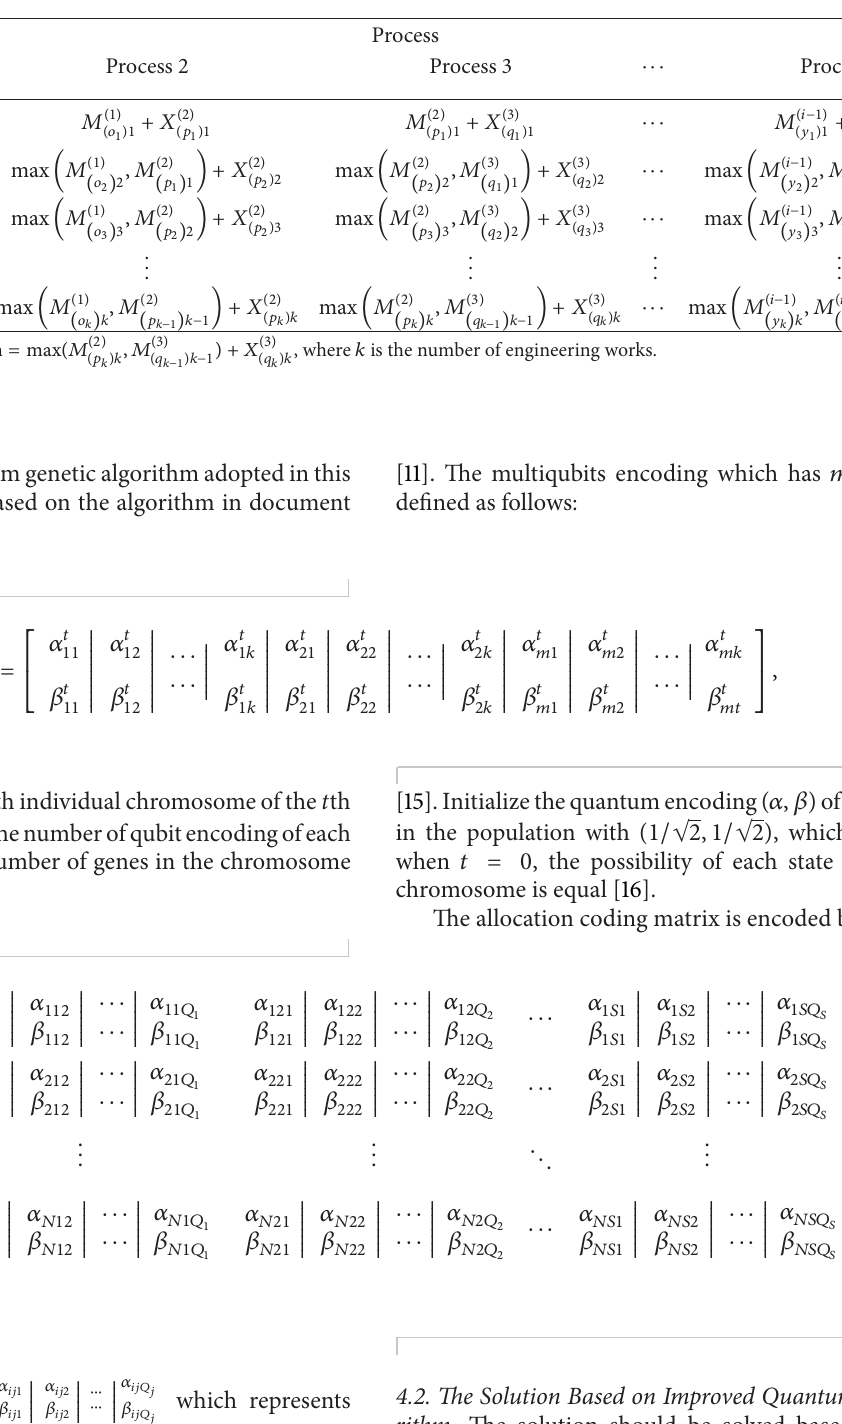
Table 2: Total time of completion of every